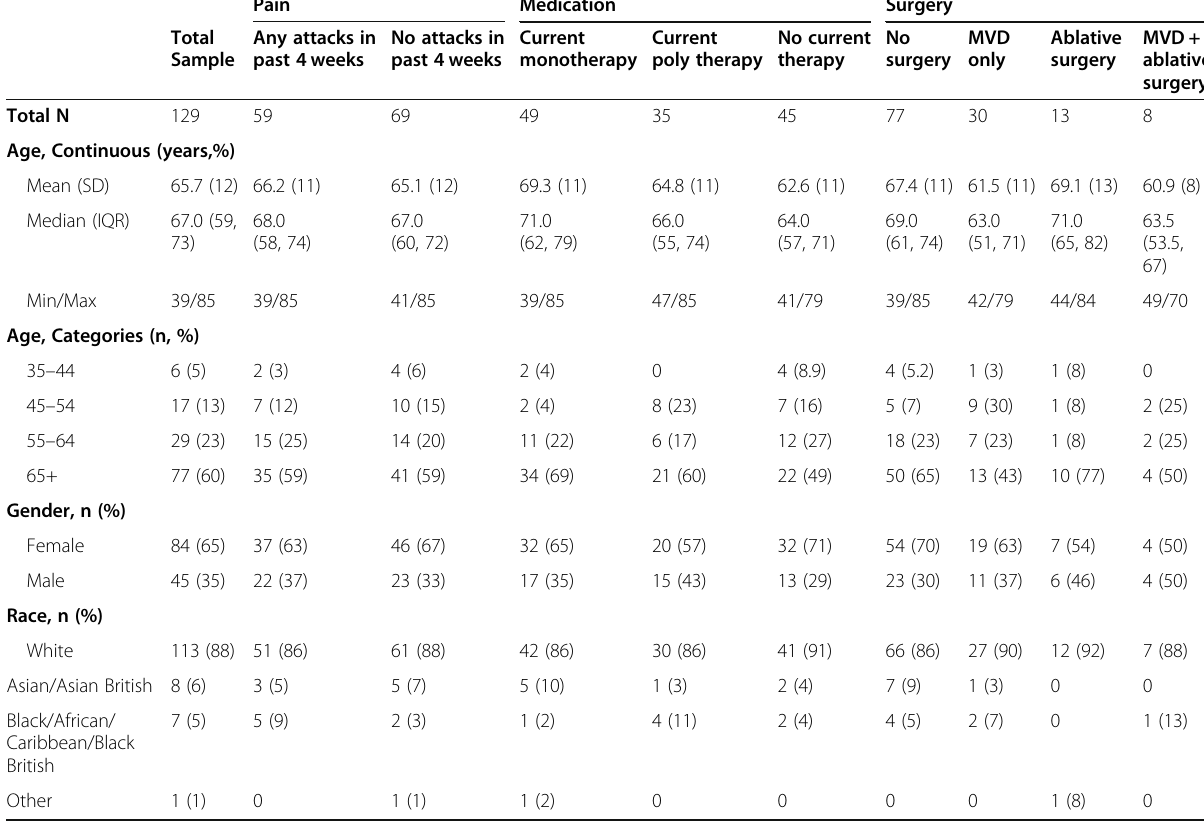
Table 1 TN Patient Demographics Stratified by Pain, Medication Use, and Surgical History a